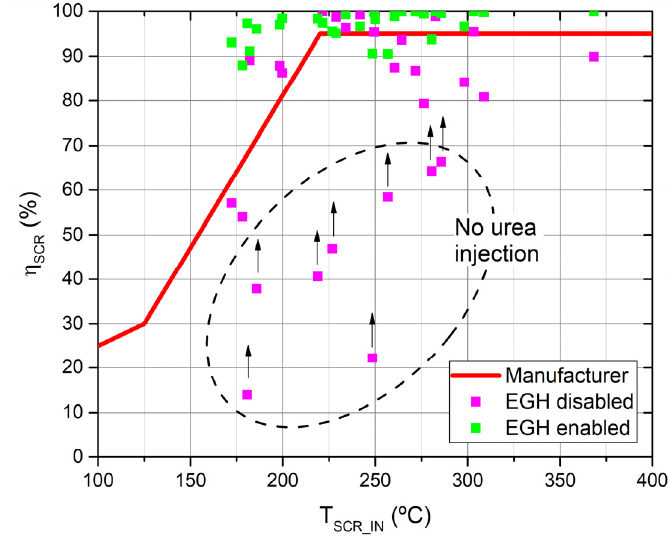
Figure 9. Theoretical and experimental SCR conversion efficiency as a function of catalyst tempera- ture